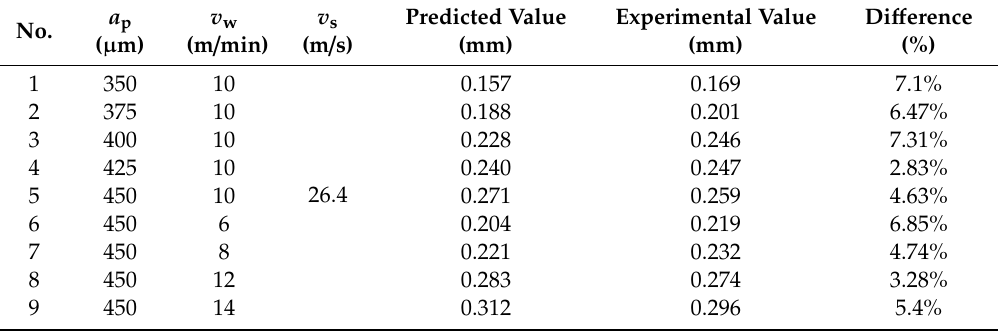
Table 4. Comparison between the predicted value and the experimental value of hardness penetration depth (HPD).